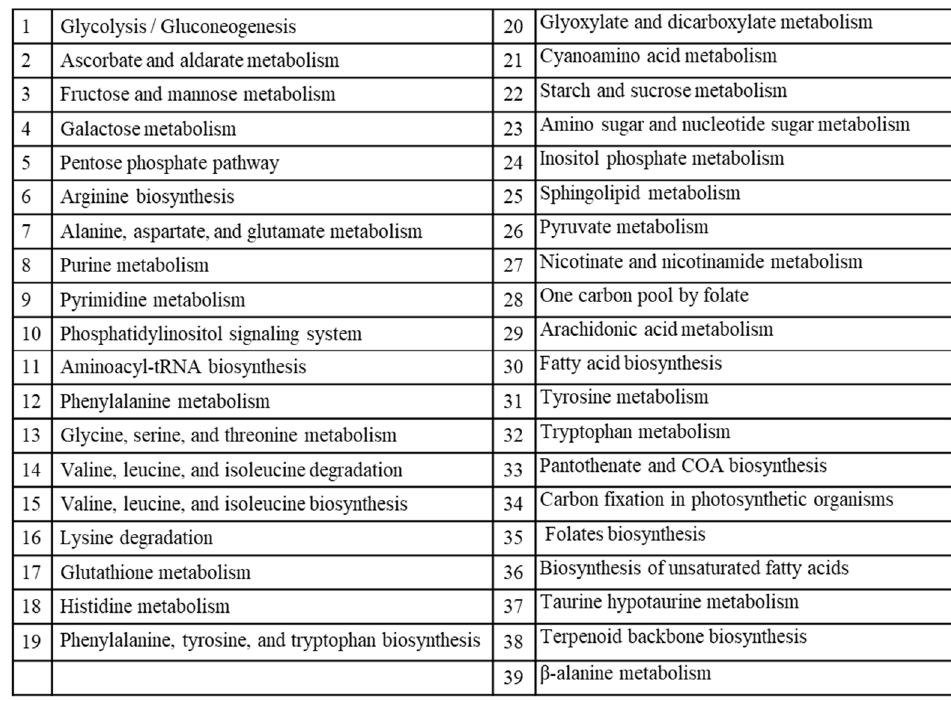
Figure 5. Overview of pathway analysis using MetaboAnalyst 4.0. For metabolite set enrichment analysis of Phragmites australis differentiating metabolic profile (DMF) after incubation with ( a ) 10 and 100 µM diclofenac; ( b ) 10 and 50 µM carbamazepine. The overview displays all matched pathways as circles. The color and size of each circle are based on the p value and the impact of the pathway value, respectively. The names of the metabolic pathways are listed in the table.